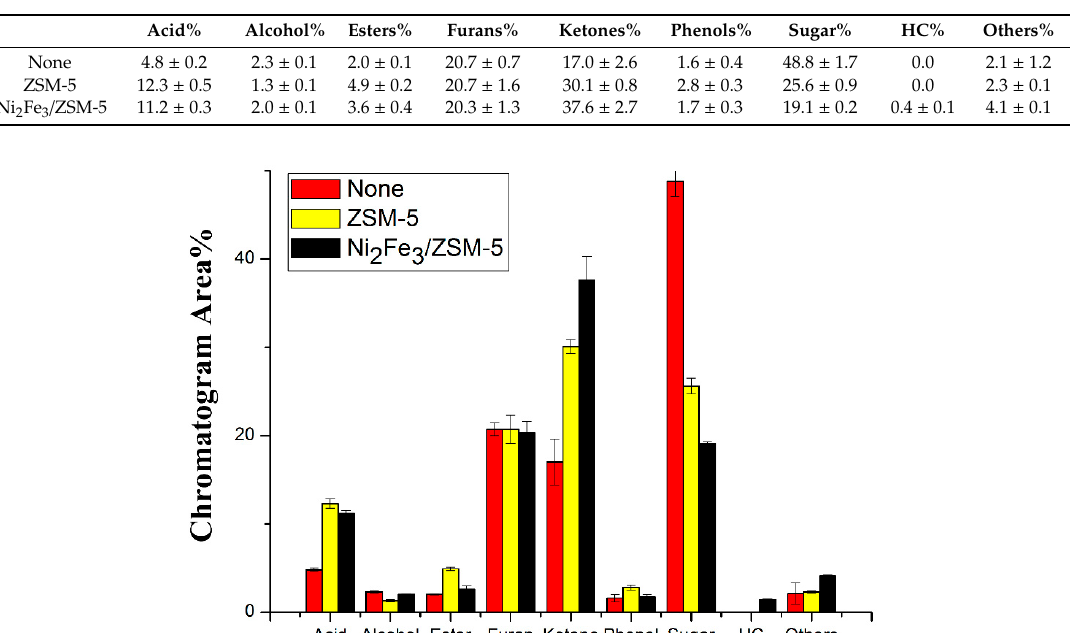
Table 2. Composition of cellulose pyrolyzed products with different catalysts (peak area% of identified peaks, unidentifiable compounds are lumped together in others category).